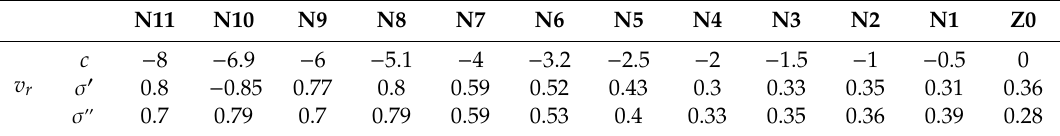
Table 4. The learning parameters of the longitudinal relative velocity.